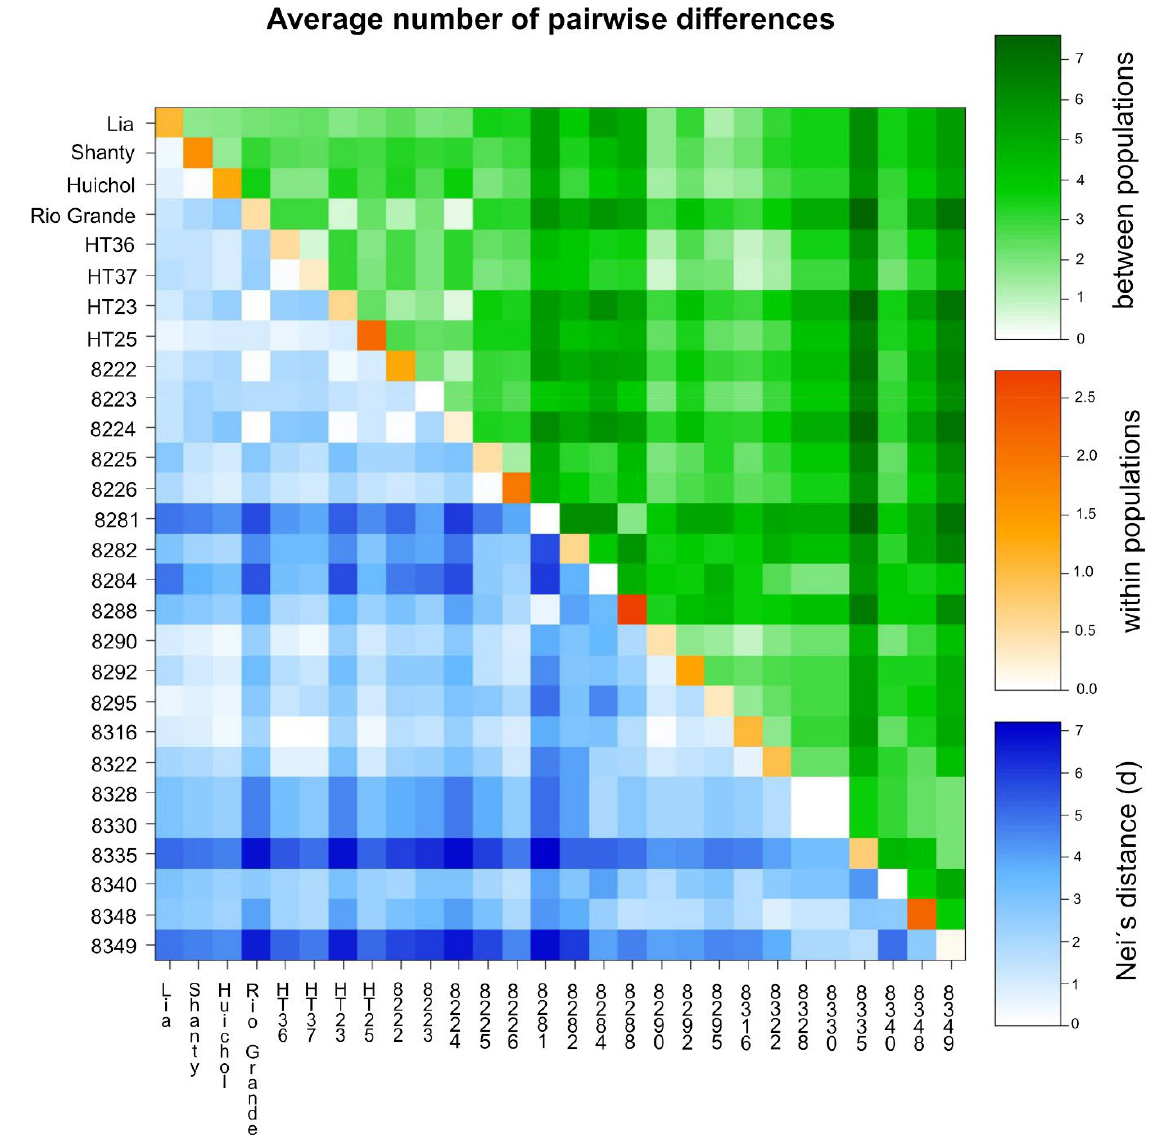
Figure 4. Heatmap displaying average number of pairwise differences of the 28 accessions, estimated using a number of different alleles as a distance method: average number of pairwise differences between the accessions (PiXY; above diagonal), average number of pairwise differences within the corresponding accession (PiX; diagonal); and corrected average pairwise difference (PiXY − (PiX + PiY)/2; below diagonal), also referred to as Nei’s distance (d).